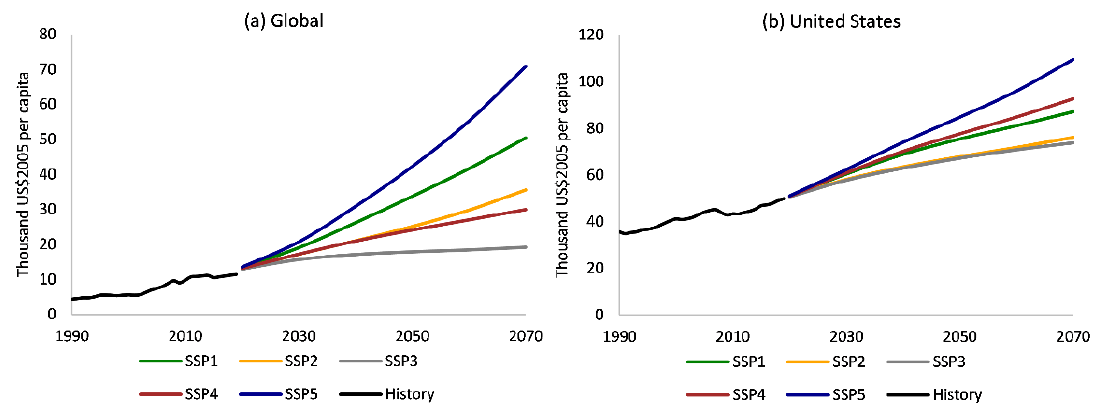
Figure 3. Historic and projected GDP per capita for IPCC Shared Socioeconomic Pathways: ( a ) global, ( b ) United States (source: [39]). Table 1 . Key exogenous drivers of global trends in the SSP scenarios * . Exogenous Driver Variable